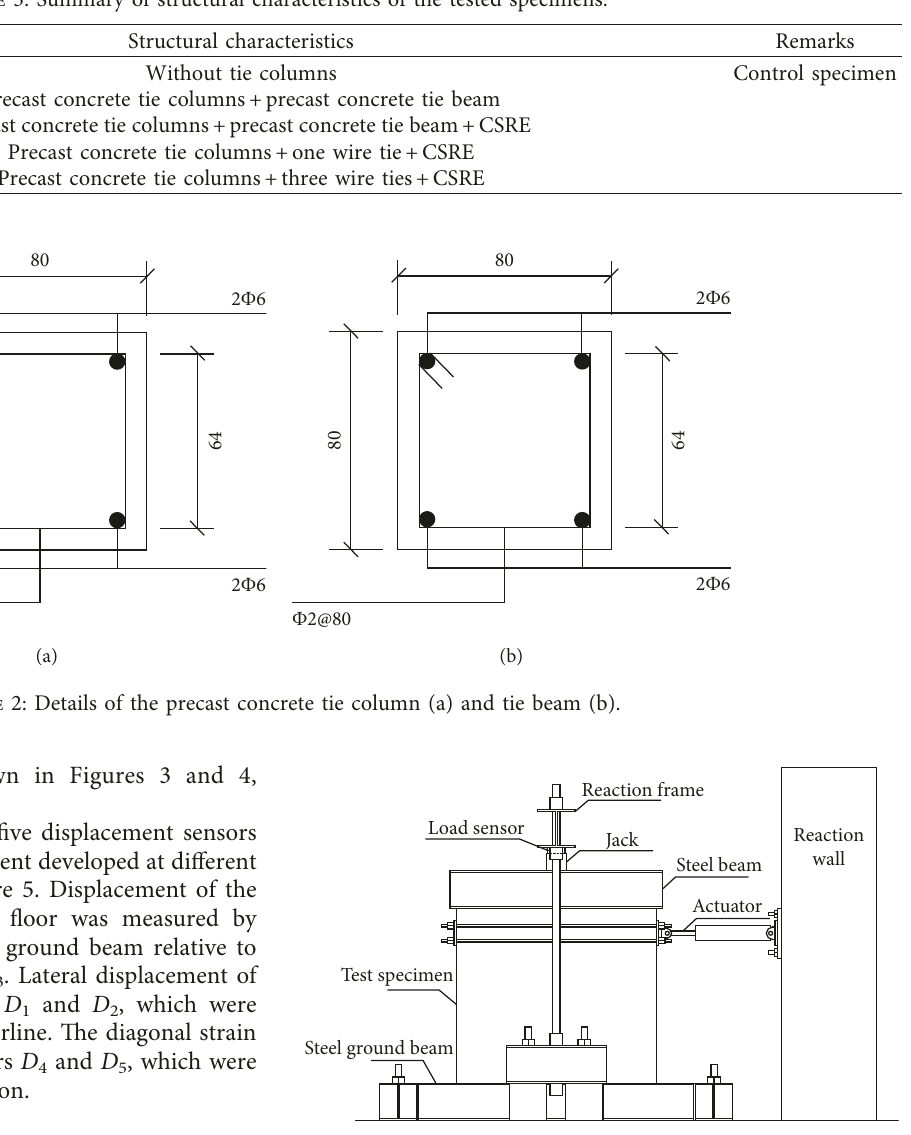
Figure 3: The schematic drawing of loading